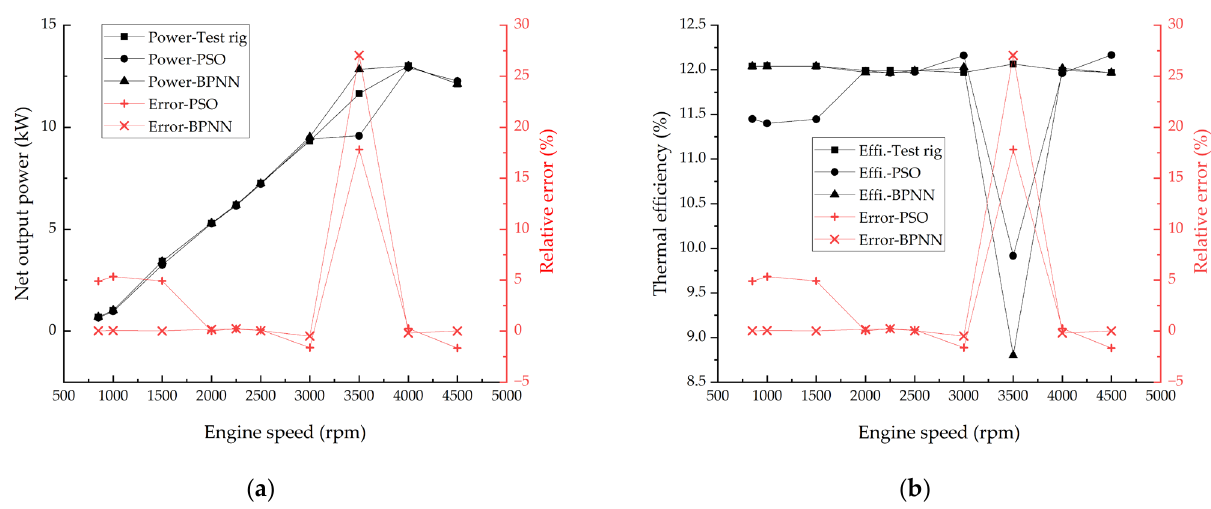
Figure 16. The comparison of the performance prediction models for the 10 test conditions with full load at different speeds: ( a ) net output power; ( b ) thermal efficiency.